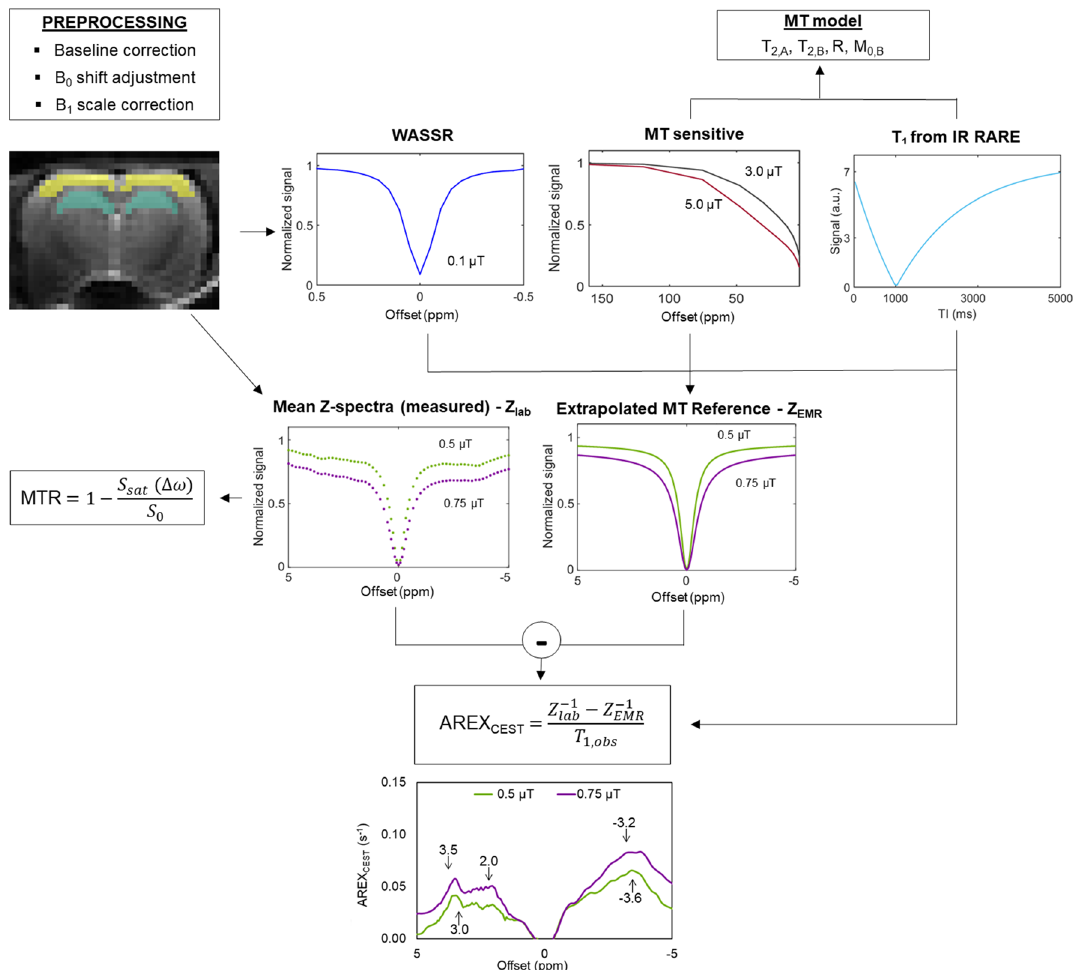
Figure 8. Graphical illustration of the analysis pipeline. First, the preprocessing steps including baseline correction, B 0 shift adjustment and B 1 scale correction were made. From two regions of interest (cortex and hippocampus), five mean Z-spectra with B 1 amplitudes of 0.1, 0.5, 0.75, 3.0 and 5.0 µT were generated. The magnetization transfer ratio (MTR) was calculated from Z-spectra acquired with B 1 s of 0.5 and 0.75 µT ( S sat , S 0 are the signals measured with and without saturation pulse, respectively). The T 1 map calculated from inversion recovery RARE images was used with MT sensitive Z-spectra (B 1 s of 3.0 and 5.0 µT) and DE-sensitive WASSR spectra (B 1 of 0.1 µT) for two-pool MT model fitting. The estimated MT model parameters were used to calculate extrapolated MT reference spectra ( Z EMR ) for B 1 s of 0.5 and 0.75 µT, representing the semi-solid- originated MT effect. Measured Z-spectra ( Z lab ) (with the same B 1 s of 0.5 and 0.75 µT) were subtracted from extrapolated MT reference spectra ( Z EMR ) providing CEST and rNOE contributions. The apparent exchange- dependent relaxation (AREX CEST ) equation was used to eliminate T 1 effect from CEST and rNOE contributions. Finally, MTR, CEST and rNOE contributions were calculated for five selected offsets (3.5, 3.0, 2.0, − 3.2 and − 3.6